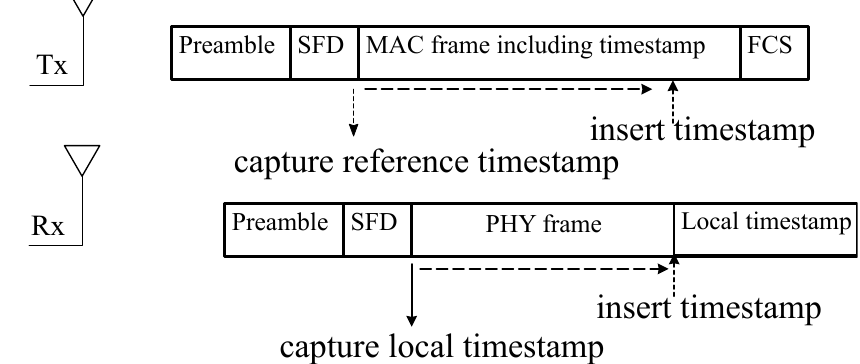
Figure 14. Considering the messaging error sources, for a system utilizing the MAC layer timestamps, only interrupt handling time cannot be avoided unless the hardware supports other means to store the receiver side timestamp. One example is presented by Asgarian and Najafi [87] for connectionless Bluetooth LE beacons.